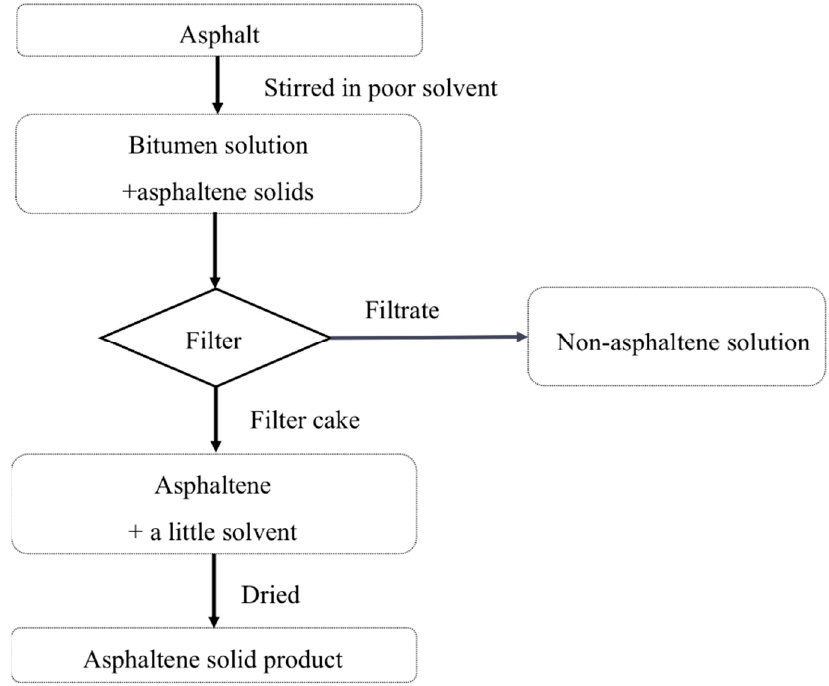
Figure 5. Flowchart for extraction of asphaltenes from bitumen at room temperature, when the amounts of inorganic impurity and carbon residues in asphalt sources are small enough.